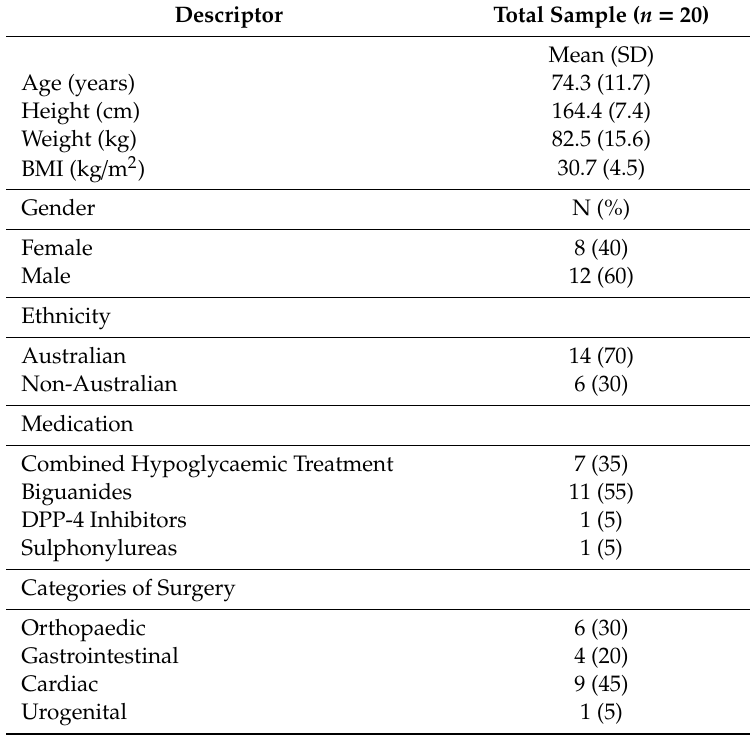
Table 2. Baseline characteristics of the study population.